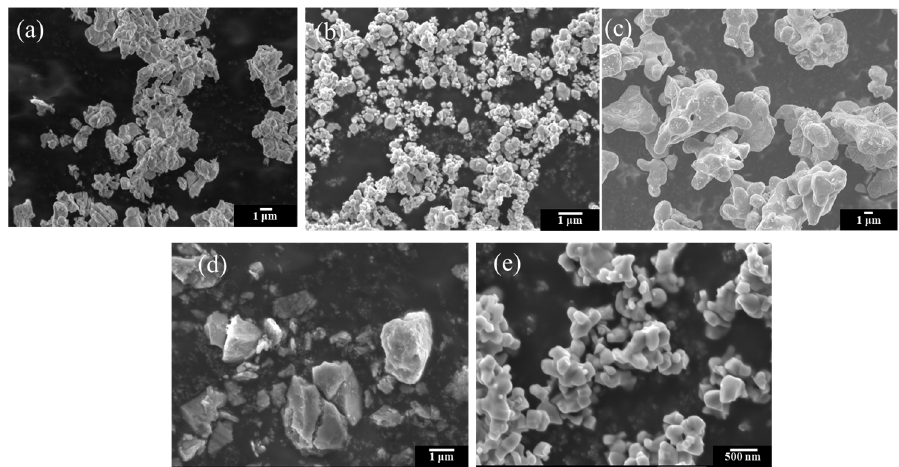
Figure 1. SEM images of the raw ( a ) La 2 O 3 , ( b ) Mo, ( c ) MoB, ( d ) Si, and ( e ) TiC powders used in this work.